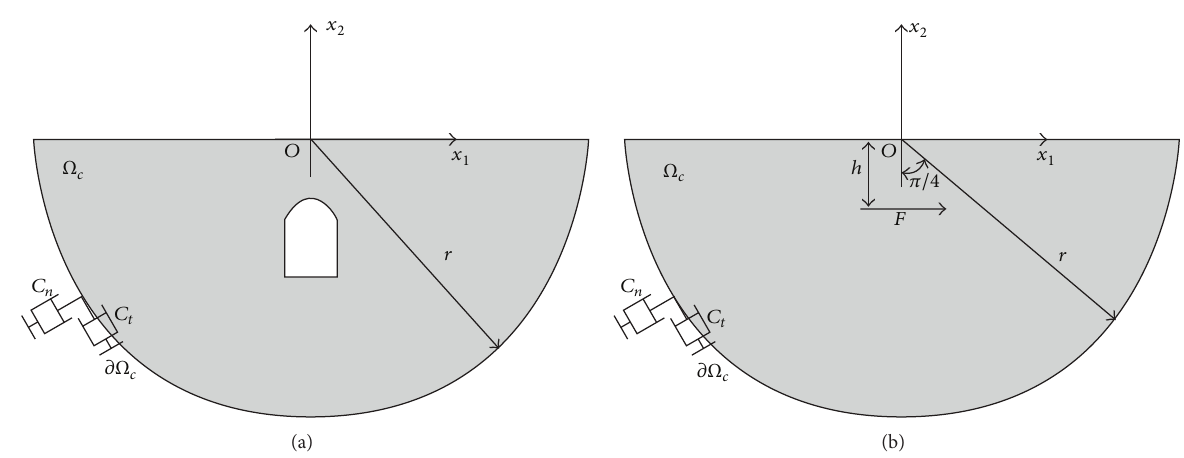
Figure 4: (a) Computational domain. (b) Problem solved to fix the radius 𝑟